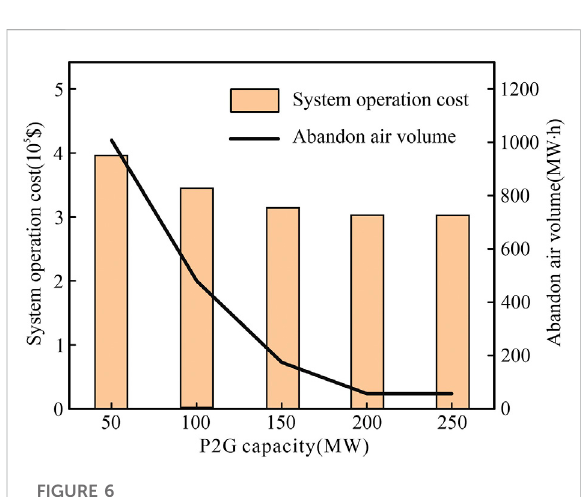
FIGURE 6 In fl uence of P2G capacity on system